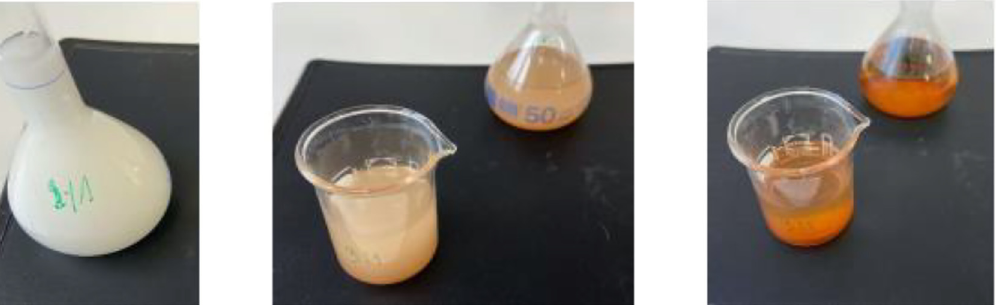
Figure3: Pantoprazolesodium – pyridoxineturnedfromwhitetoorangeaftera1-hstorageandprecipitatedatthe9/1ratio(left:T0H,middle: T 1H, right: T